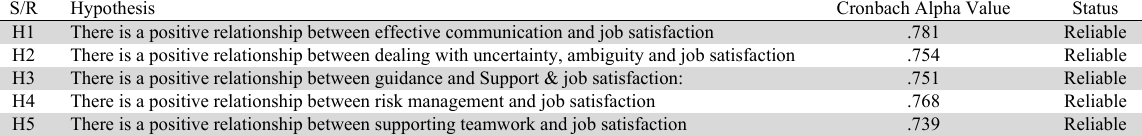
Intercoder Reliability Analysis of the Research Instrument S/R